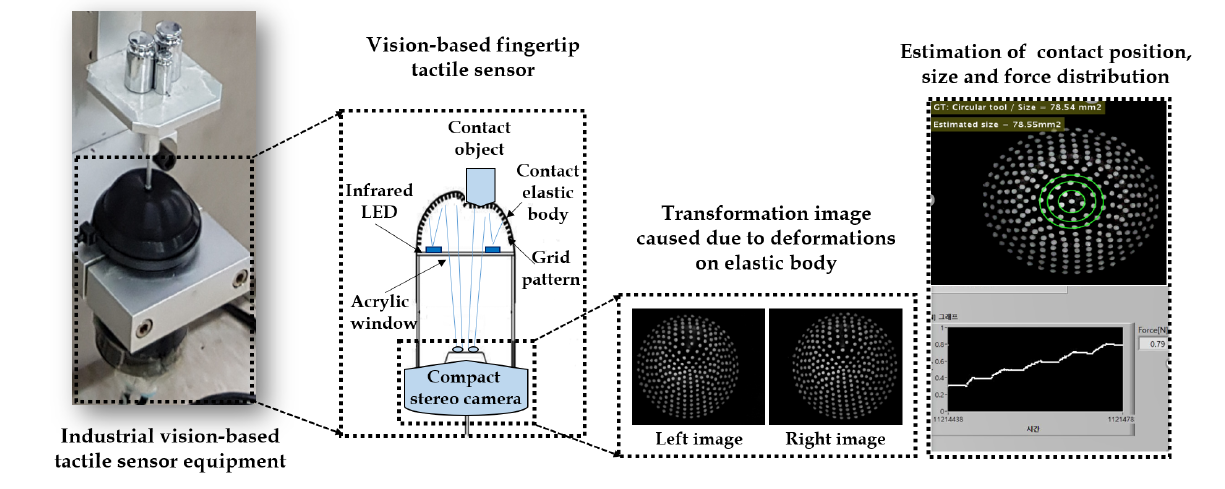
Figure 1. Principle of detection in vision-based tactile sensor